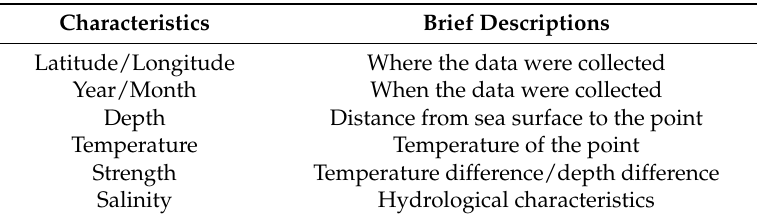
Table 1. Characteristics and their